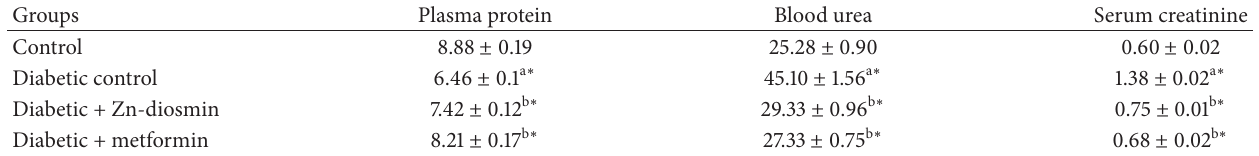
Table 3: Effect of Zn-diosmin complex on plasma protein and blood urea and serum creatinine levels in rats after 30-day treatment.